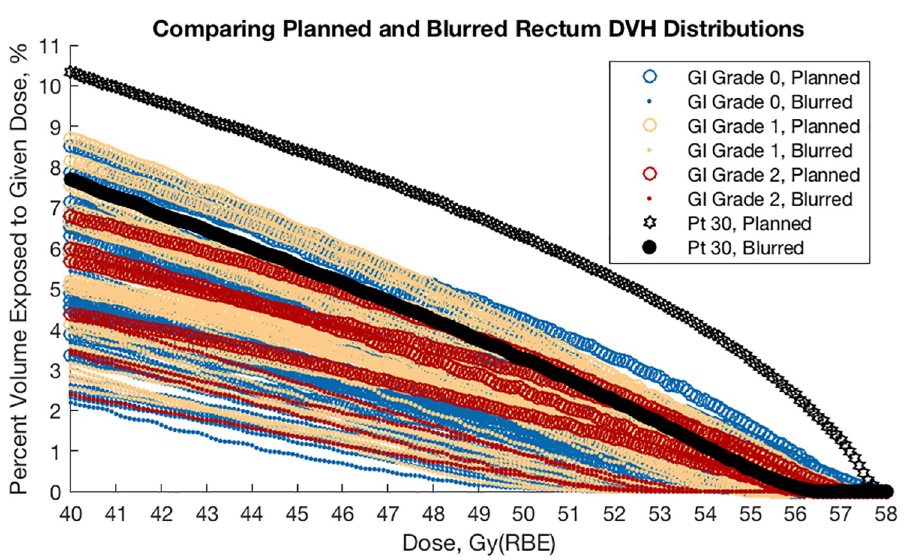
Fig 11. Comparison of patient 30’s rectum DVH with the sampled patients reporting gastrointestinal (GI) toxicity. Planned and blurred rectum DVH are color-coded by maximum GI toxicity reported upon follow-up examination.